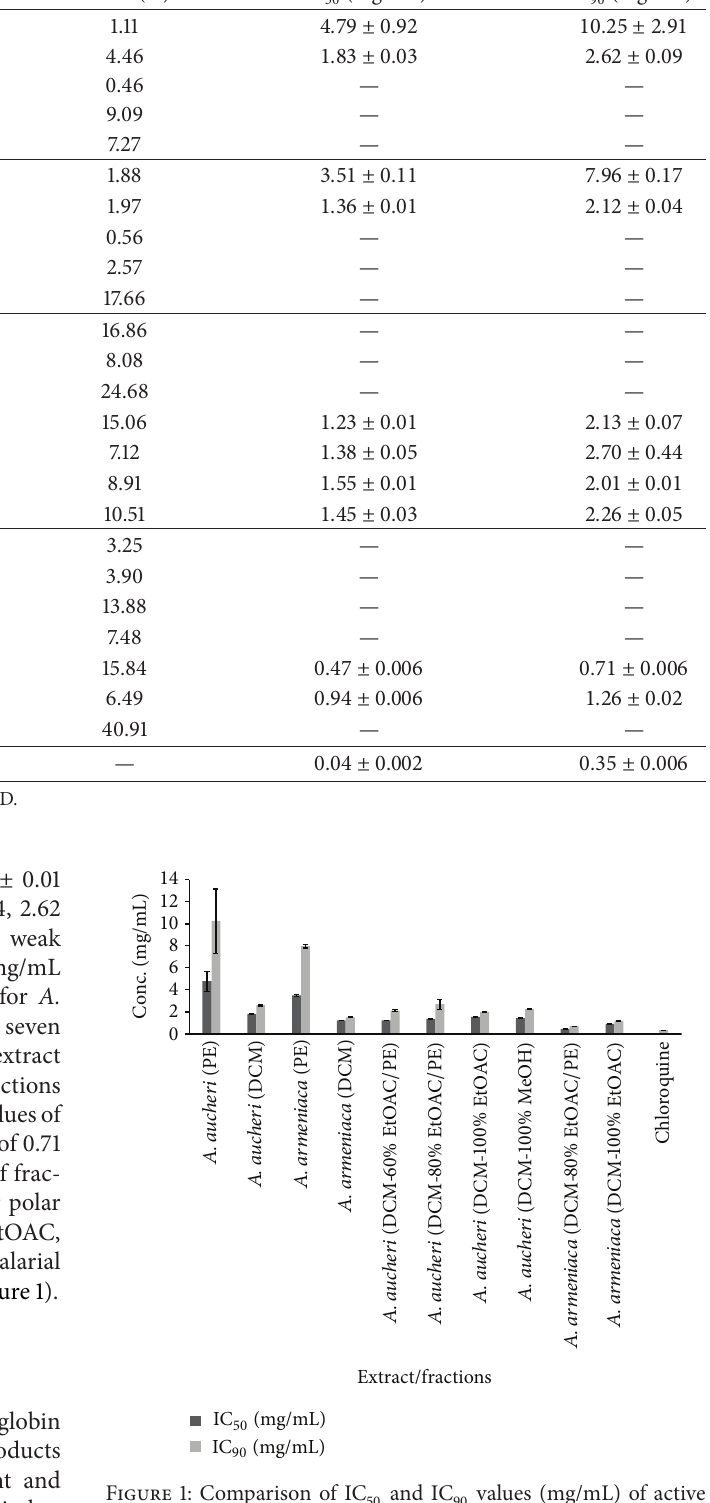
Figure 1: Comparison of IC 50 and IC 90 values (mg/mL) of active extracts and fractions of A. armeniaca and A. aucheri and chloro- quine solution in 𝛽 -hematin formation assay. The values were reported as Mean ±